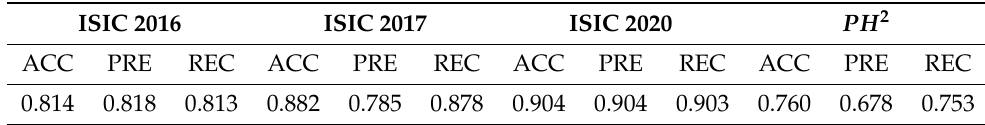
Figure 5. Classification accuracy and loss curves of the LCNet with the number of epochs on the validation set ( a ) MEL vs. BEN lesion classes ISIC 2016 ( b ) MEL vs. SK and NV lesion classes ISIC 2017 ( c ) MEL vs. BEN lesion classes ISIC 2020. Table 6. Performance of the LCNet on the adopted datasets.